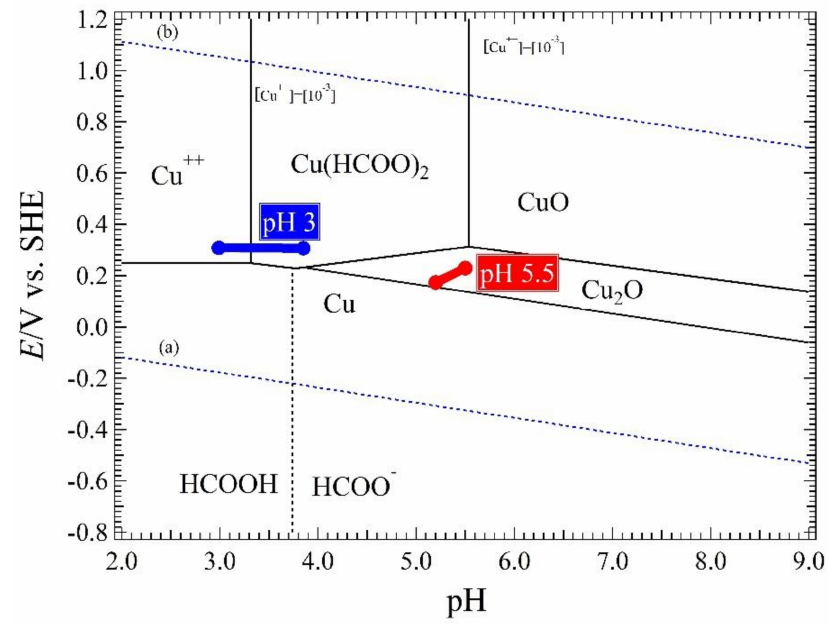
Figure 12. E -pH Diagram of Cu and Cu(HCOO) 2 with pH condition 5.5, with the assumption that the concentration of total dissolved copper ions [Cu ++ ] was 10 − 3 mol kg − 1